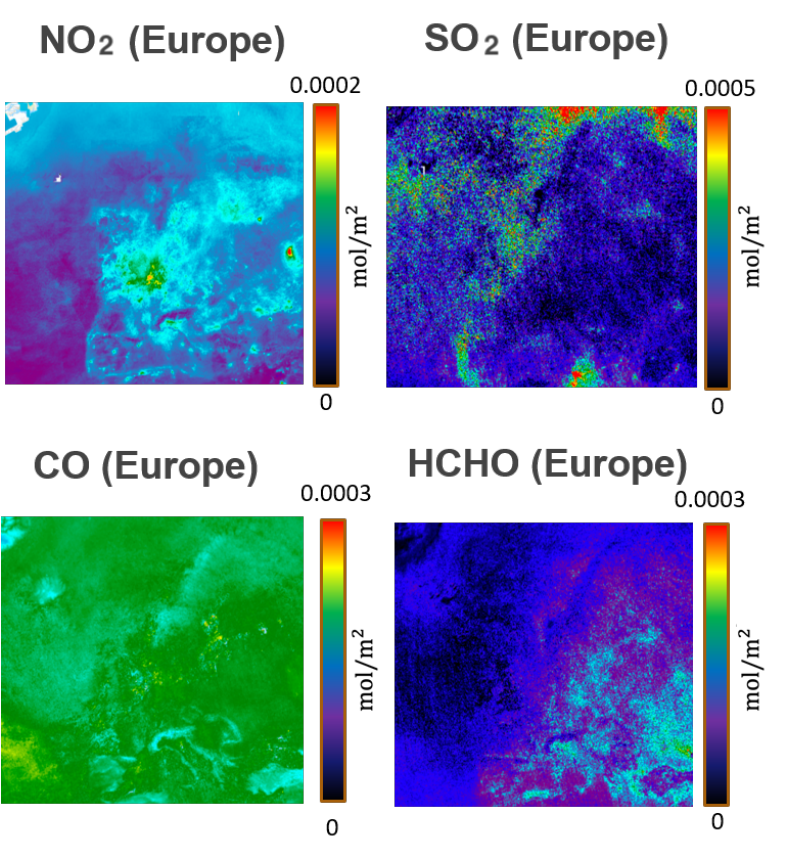
Figure 9. Sample of Sentinel-5P pollution data.